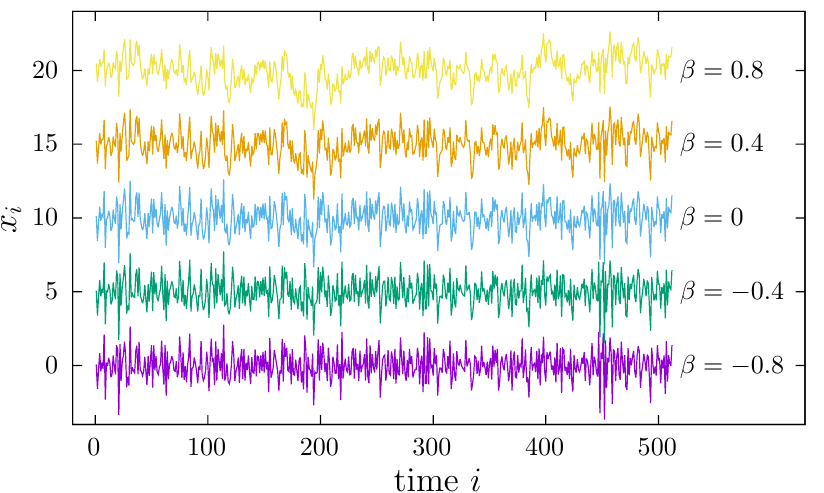
Figure 1. Correlated time series with a power spectrum of the form S ( f ) Fourier Filtering Method for several β values. In all cases, the time series length is N = 512. All series have 0 mean and unit standard deviation, but we have shifted them vertically to avoid